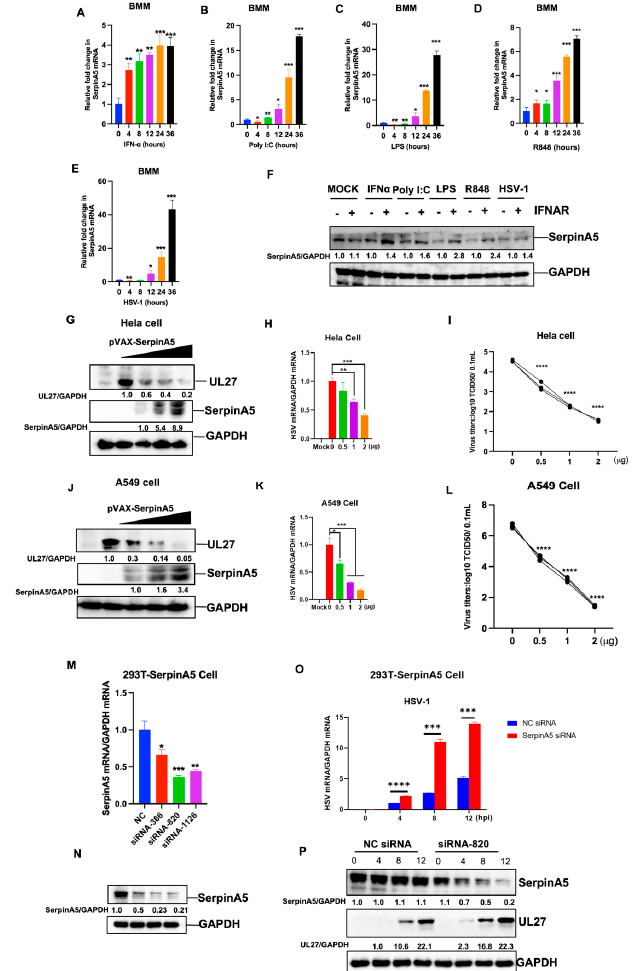
Figure 1. SerpinA5 is an IFN-stimulated gene with antiviral function. ( A – E ) BMM cells were stimulated with IFN- α (2000 U/mL), Poly I:C (25 µ g/mL), R848 (100 nM), and HSV-1 (MOI = 0.5), respectively, and then the expression of SerpinA5 was detected by qPCR. The expression level of mRNA was normalized to the expression of GAPDH, and the data from at least triplicates were shown as the mean ± SD. * p < 0.05, ** p < 0.01, *** p < 0.001. ( F ) Wild-type bone marrow-derived macrophage (WT-J2-BMM) cells or interferon α receptor-deficient (IFNAR − / − )-J2-BMM cells were stimulated with IFN- α (2000 U/mL), poly I:C(25 µ g/mL), R848 (100 nM), and HSV-1 (MOI = 0.5) for 24 h, respectively, and then the expression of SerpinA5 protein was measured by Western blot analysis. GAPDH was used as an internal control. The relative ratios of SerpinA5 and GAPDH were marked at the bottom of the pictures. ( G – I ) Hela cells were transfected with 0, 0.5, 1 or 2 µ g of Pvax-SerpinA5-expressing plasmids for 24 h. The cells were then mock-infected or infected with HSV-1 (MOI = 0.5) for 12 h. The expression of viral proteins ( J ) and viral RNA ( K ) were detected by Western blotting and qPCR, respectively. The virus yields were measured by TCID50 assay ( L ). ( J ) A549cells were transfected with 0, 0.5, 1 or 2 ug of Flag-SerpinA5-expressing plasmids for 24 h. The cells were then mock-infected or infected with HSV-1 for 12 h. The expression of viral proteins and viral RNA were detected by Western blotting and qPCR, respectively. ( M , N ) 293T- SerpinA5 cells were transfected with 120 nM of negative control (NC) siRNA or SerpinA5 siRNA (siRNA- 366, siRNA-820 siRNA-1126) for 24 h, the knockdown efficiency of each siRNA was then evaluated by qPCR and Western blotting analysis, respectively. ( O ) 293T-SerpinA5 cells were transfected with 120 nM of NC siRNA or SerpinA5 siRNA (siRNA-820) for 24 h, and the cells were then infected with HSV-1 (MOI = 0.5) for 0, 4, 8 or 12 h. The expression of viral proteins and viral RNA ( P ) were detected by Western blotting and qPCR, respectively. Data from at least triplicates were shown as the mean ± SD. * p < 0.05, ** p < 0.01, *** p < 0.001, **** , p <